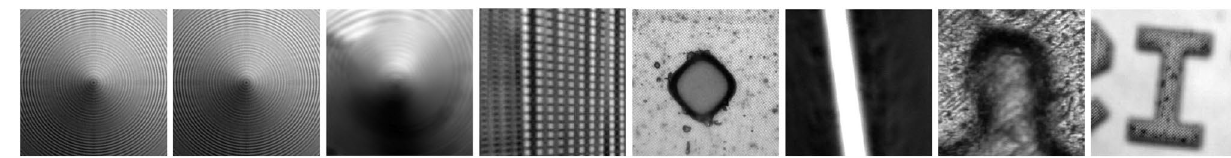
Figure 5. 10th frame of image sequence of each experimented object. (left to right) Simulated Cone with b ) 2 σ 2 2 a 2 σ 4 σ 2 ( 2 ak ξ = ζ + ζ , where +